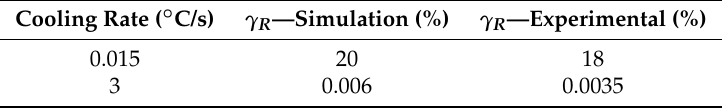
Table 4. Comparison between the volume fractions of retained austenite ( γ R )